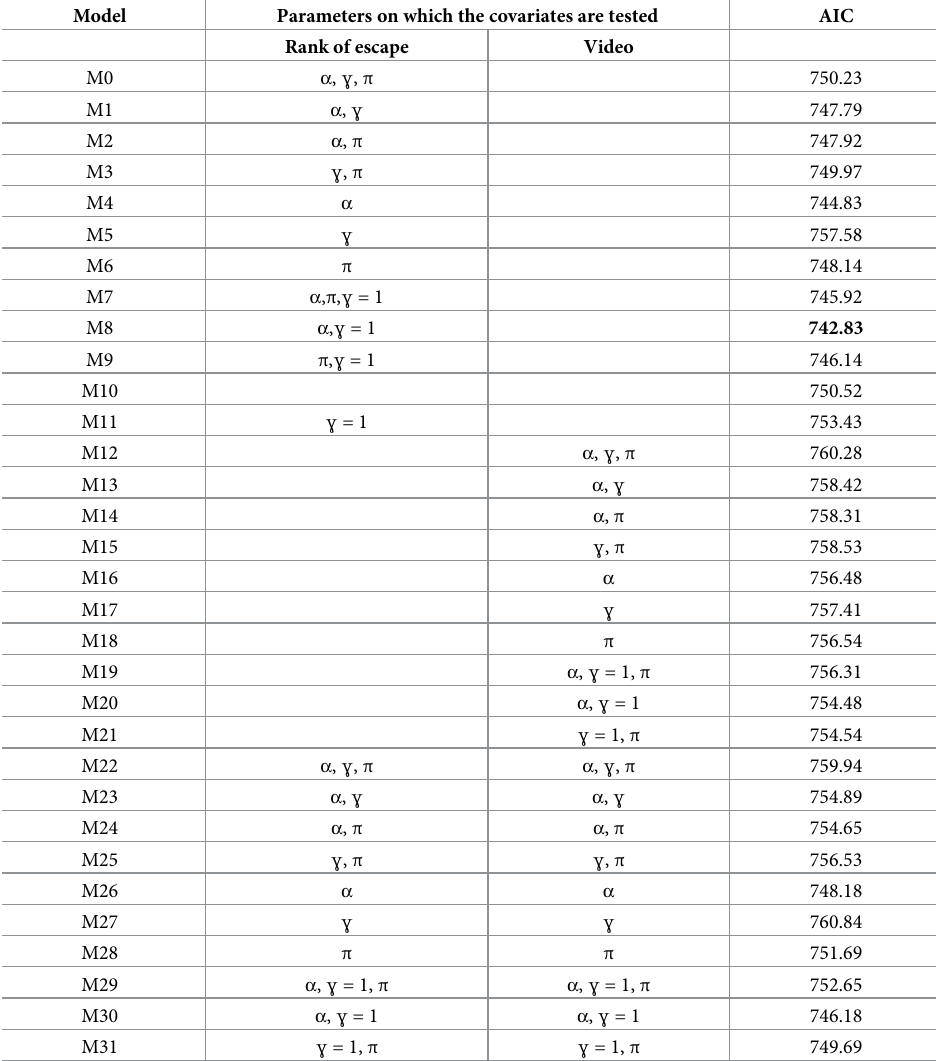
Table 1. Escapement